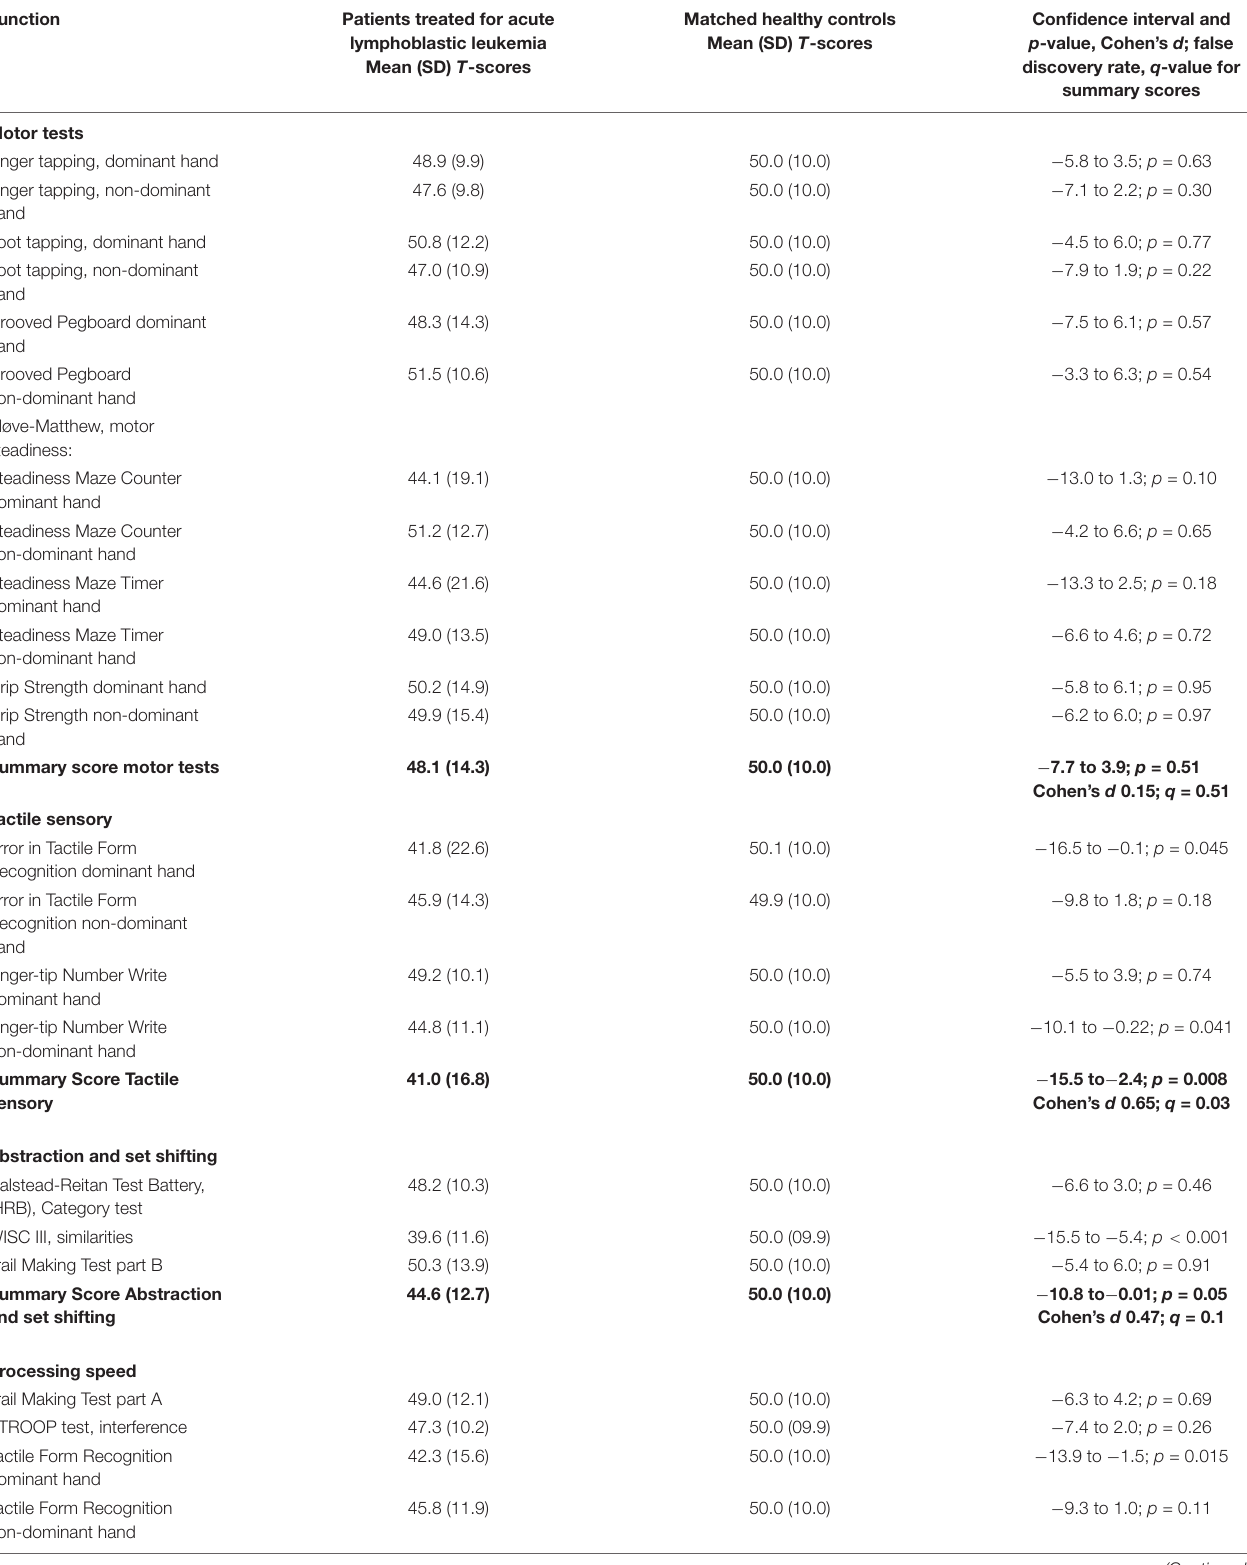
TABLE 2 | Independent sample t -test on neuropsychological test results in 36 ALL survivors compared to 36 matched (matched for age education and socio-economic parent status) healthy controls. Function Patients treated for acute